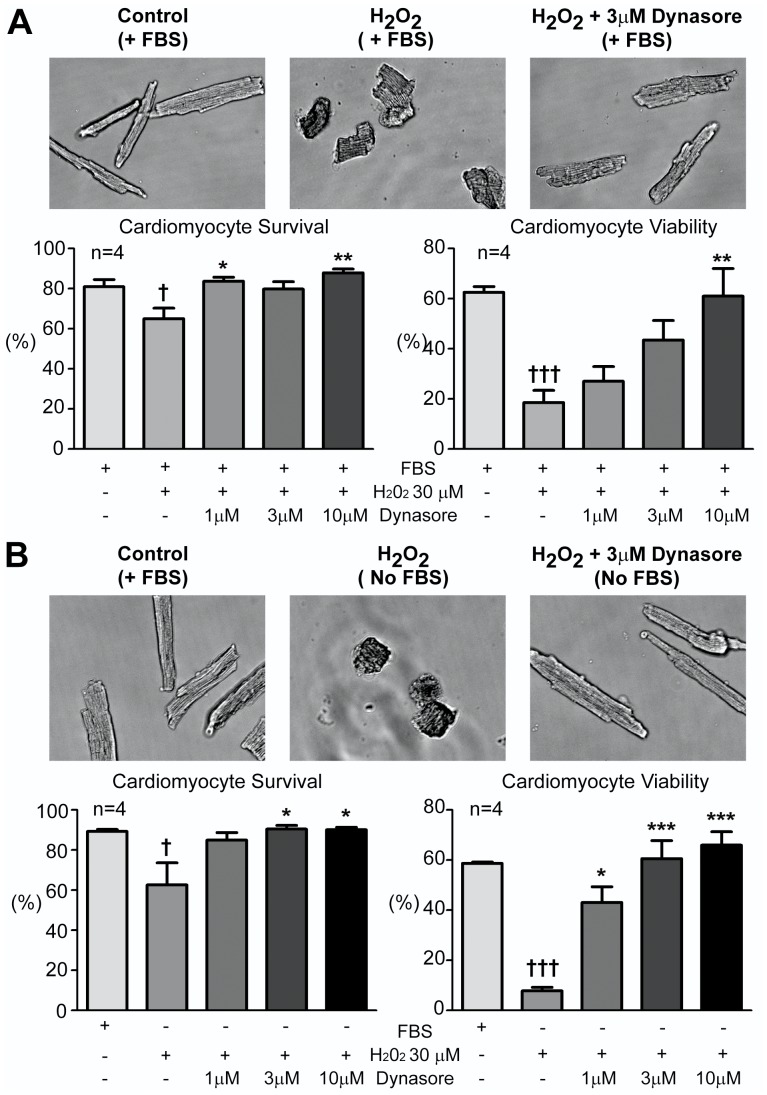
Dynasore increasses cardiomyocyte survival and viability.Trypan blue exclusion assay was used to identify cell survival and viability of cardiomyocytes subjected to oxidative stress in the presence (A) and absence of FBS (B). A. Dynasore increases cell survival and viability in oxidative stressed (exposed to 30µM H2O2 for 35 min) cardiomyocytes. Top, representative phase images of cardiomyocytes. Bottom, summarized cell survival and viability results. B. Dynasore further increased cell survival and viability in serum depleted and oxidative cardiomyocytes. Top, representative phase images of cardiomyocytes. Bottom, summarized cell survival and viability results. (** P<0.01, ***P<0.001 when compared to stressed cardiomyocytes without Dynasore treatment; † P<0.05, ††† P<0.001 when compared to non-stressed cardiomyocyte controls).